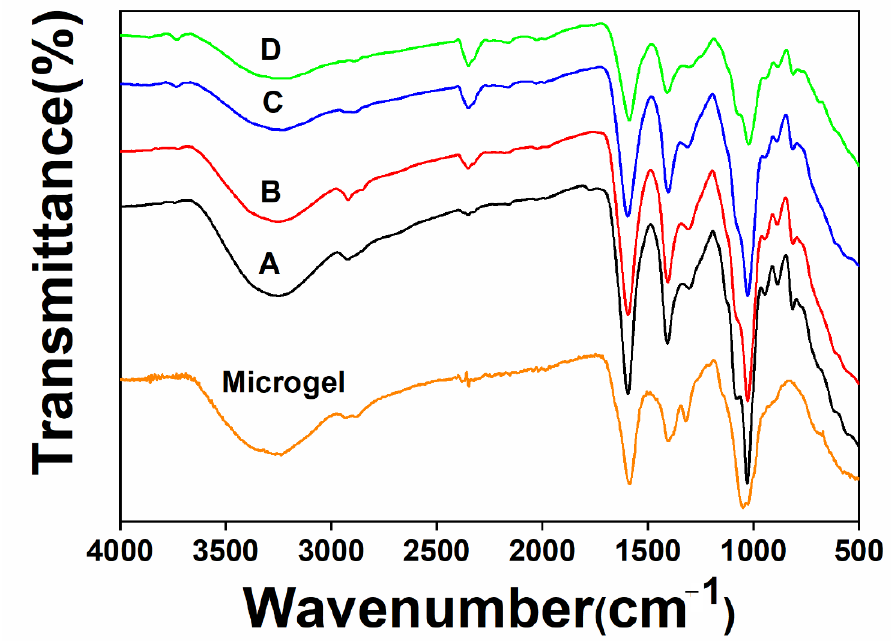
Figure 3 . FT-IR spectra of the microgels and hydrogels. Figure 3. FT-IR spectra of the microgels and